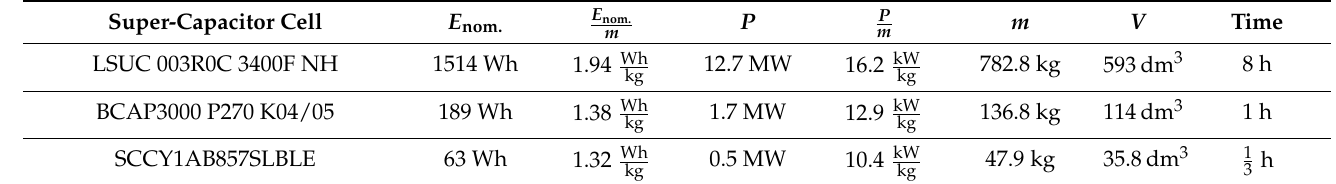
Table 4. Electrical and physical specifications of super-capacitor modules based on SESS.